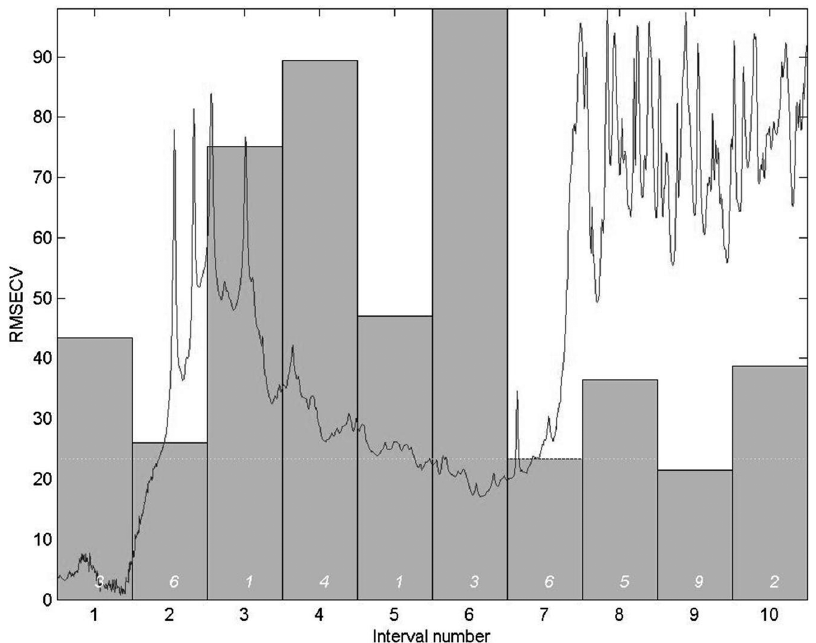
Figure 3 - Cross-Validated Prediction Errors (RMSECV) values for full-spectrum model and interval models (bars) for the SMZ determination using PLS and iPLS algorithms (dotted line and numbers above interval numbers refer to full-spectrum RMSECV and latent variables used in each model, respectively).